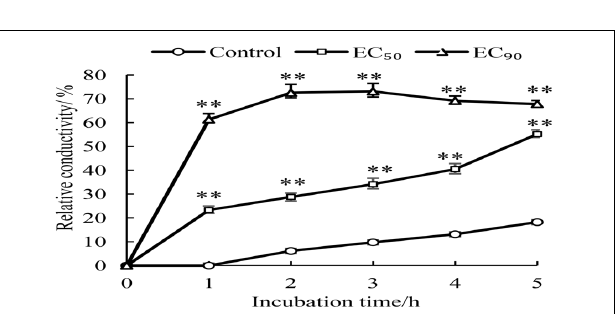
FIGURE 3 | Effects of different concentrations of GO on extracellular conductivity of P. microspora . Each value is the mean for three replicates. The vertical bar indicates the standard error. The asterisks indicate significant difference between control and GO treated fruit ( ∗∗ P <